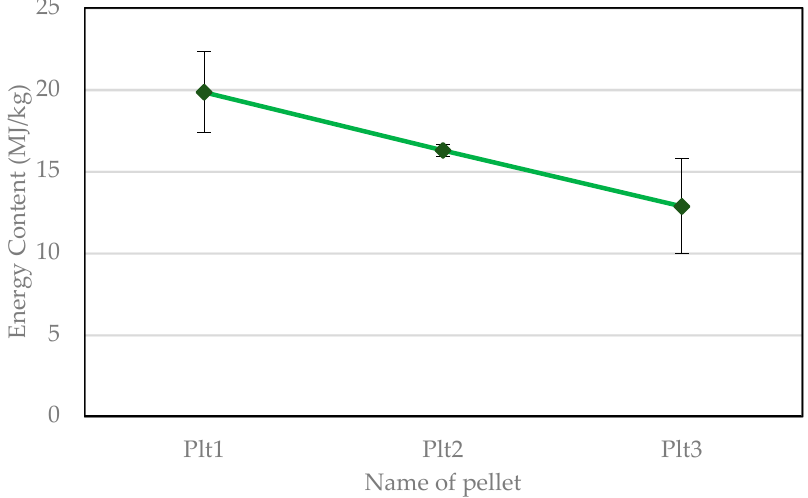
Figure 8. Comparison of the energy content of pellets composed of seaweed, sawdust, and hay. According to ENplus and CANplus, the minimum energy content of standard wood pellets is 16.56 MJ/kg [15]. The average energy content of seaweed pellets is very close to the minimum energy content of standard wood